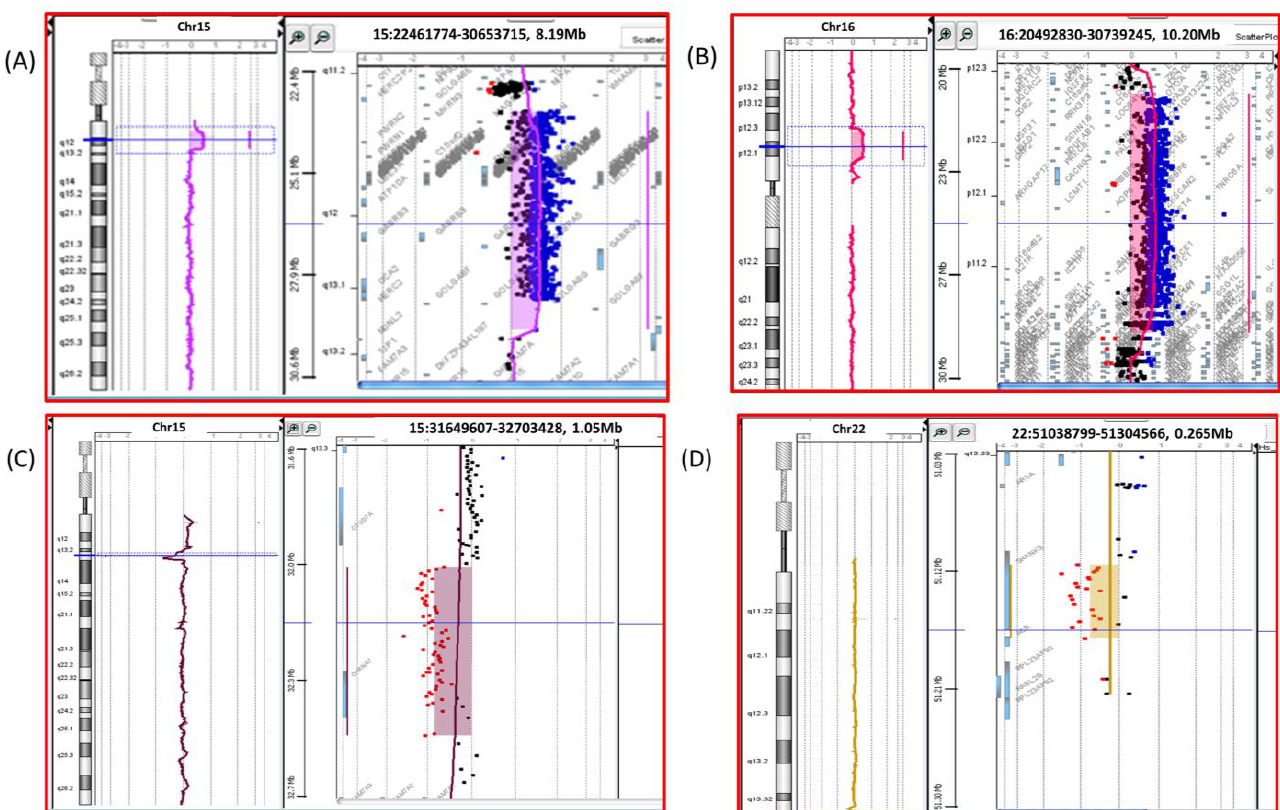
Figure 2. Representative cases of large and small duplications/deletions. ( A ) CMA shows an 8.19 Mb duplication on chromosome 15, ( B ) CMA shows a 10.2 Mb duplication on chromosome 16, ( C ) CMA shows a 1.05 Mb deletion on chromosome 15, and ( D ) CMA shows a 265 Kb deletion on chromosome 22.